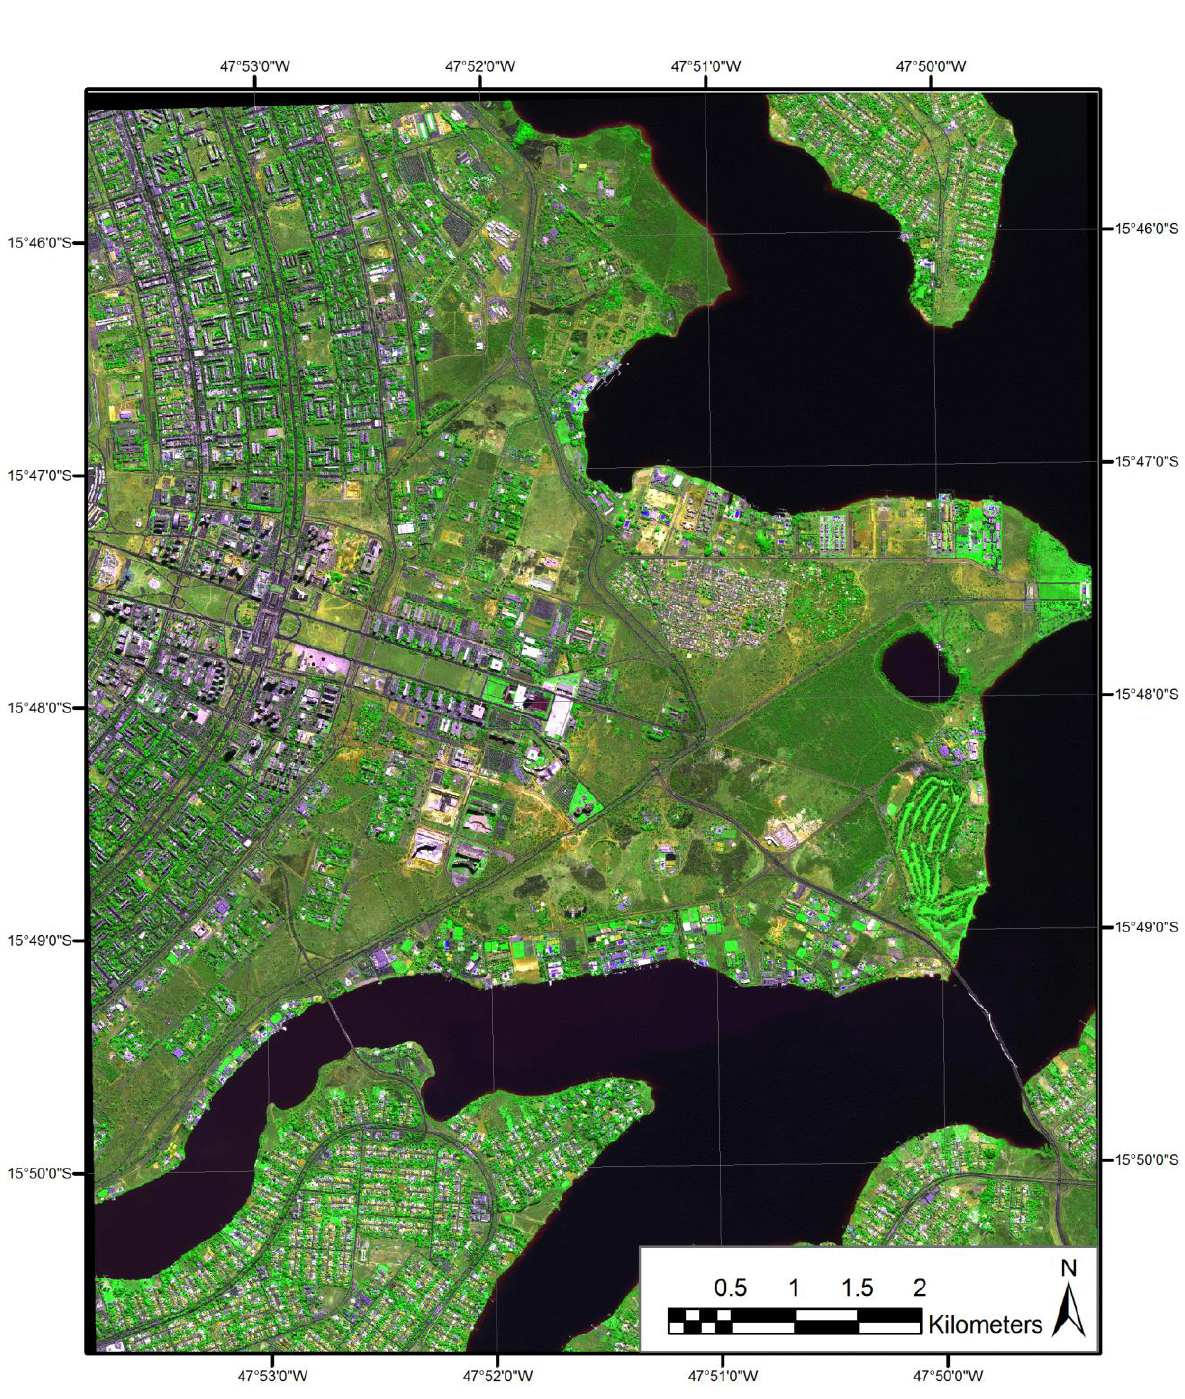
Figure 11. Previously shown in [27]. ( a ) WorldView-2 T1 image, 2 m spatial resolution, acquisition date 2010-08-04, at 13:32 GMT, radiometrically calibrated into TOARF values, depicted in false colors (R: 5, G: 7, B: 2). A linear contrast stretch is automatically applied by the adopted image processing commercial software toolbox, which alters the spectral content of the image for visualization purposes (e.g., in this case greenness is augmented). An expert photointerpreter must be aware of this spectral distortion affecting the depicted image. ( b ) Q-SIAM™ preliminary map of the WorldView-2 image shown in (a). Output spectral categories are depicted in pseudo colors. Map legend: refer to Table